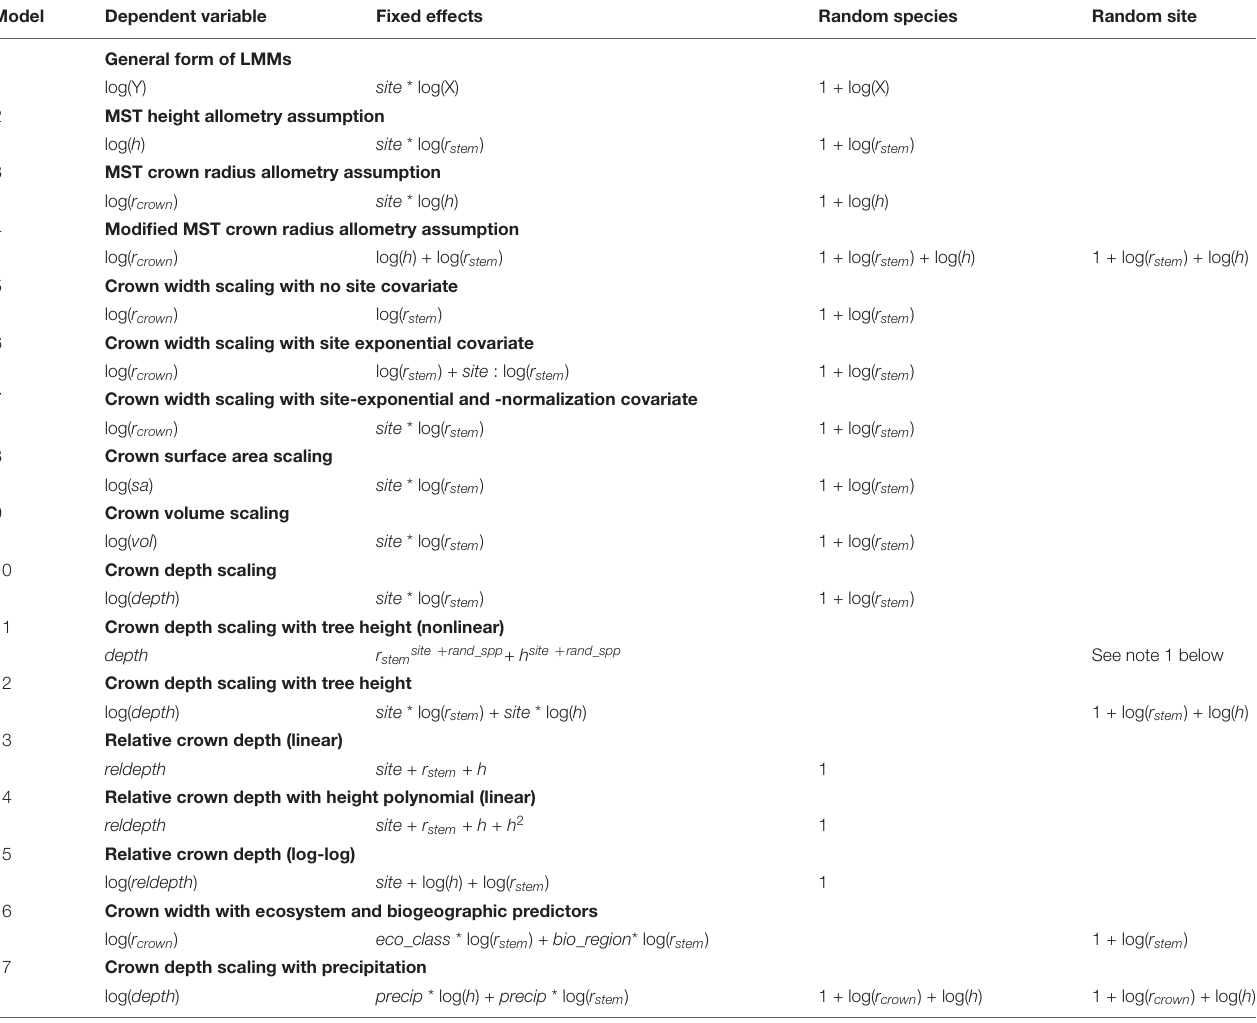
TABLE 2 | List of modeling equations employed in this study.